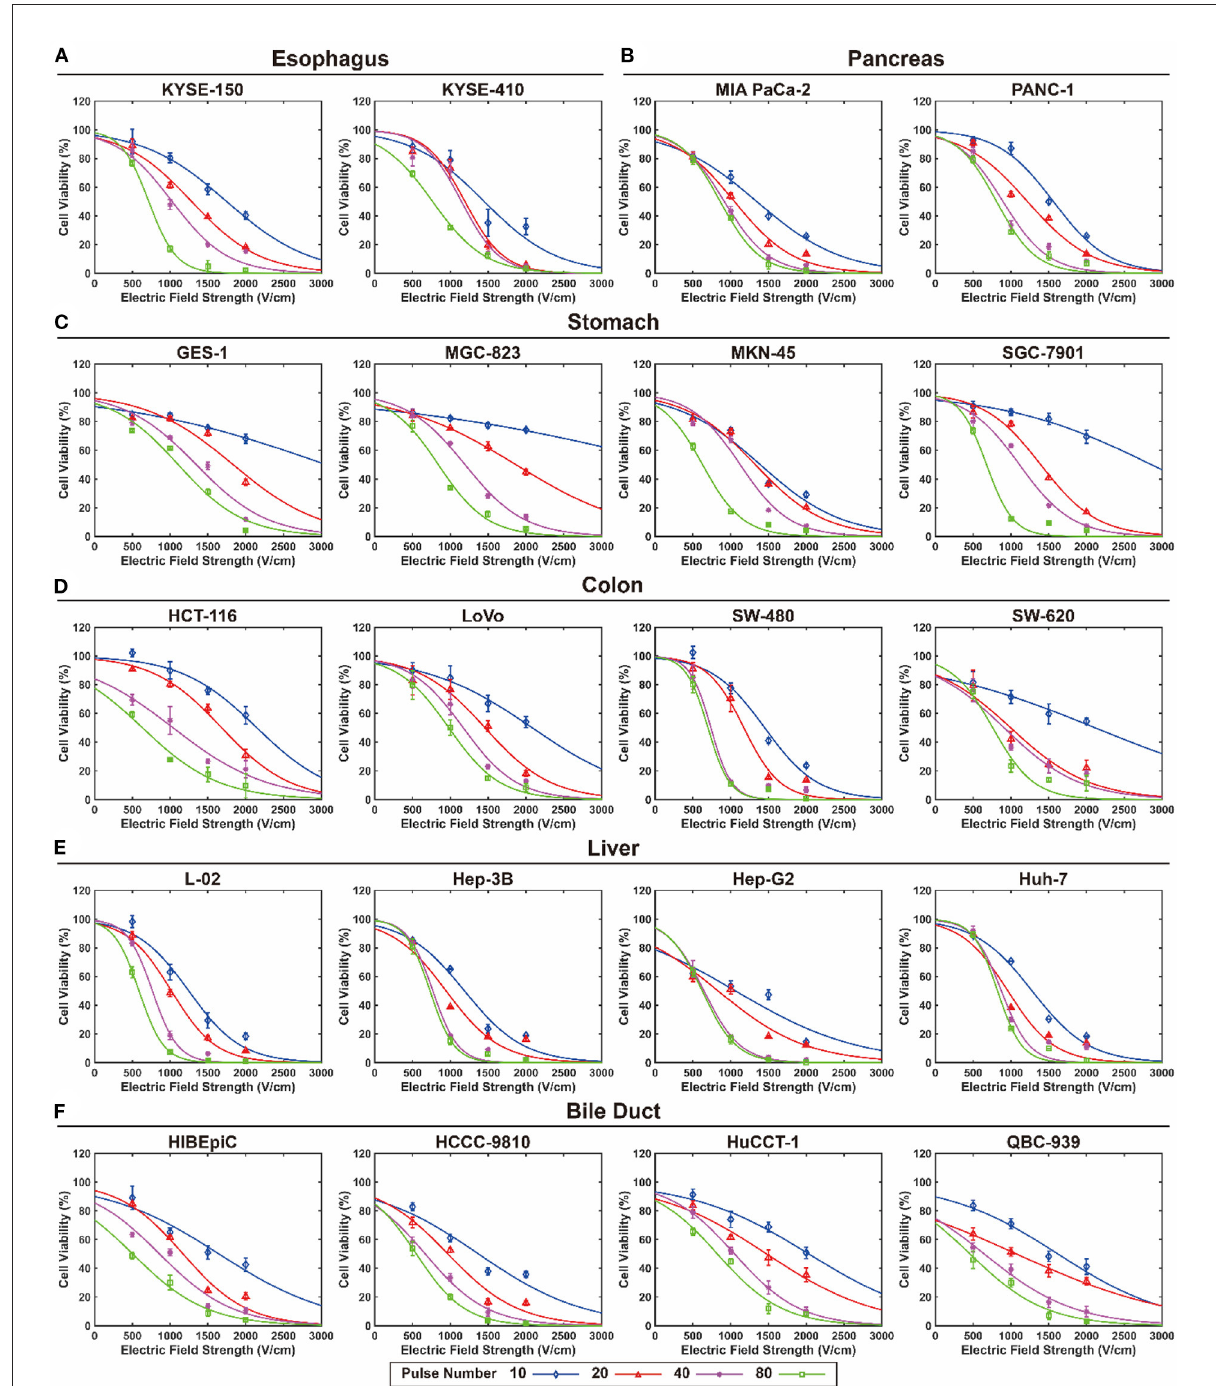
FIGURE3 Survival curve of each cell line exposed to electroporation pulses with different pulse number and electric fields strength under 100 µ s pulse duration. (A) Esophagus, (B) pancreas, (C) stomach, (D) colon, (E) liver, and (F) bile duct.